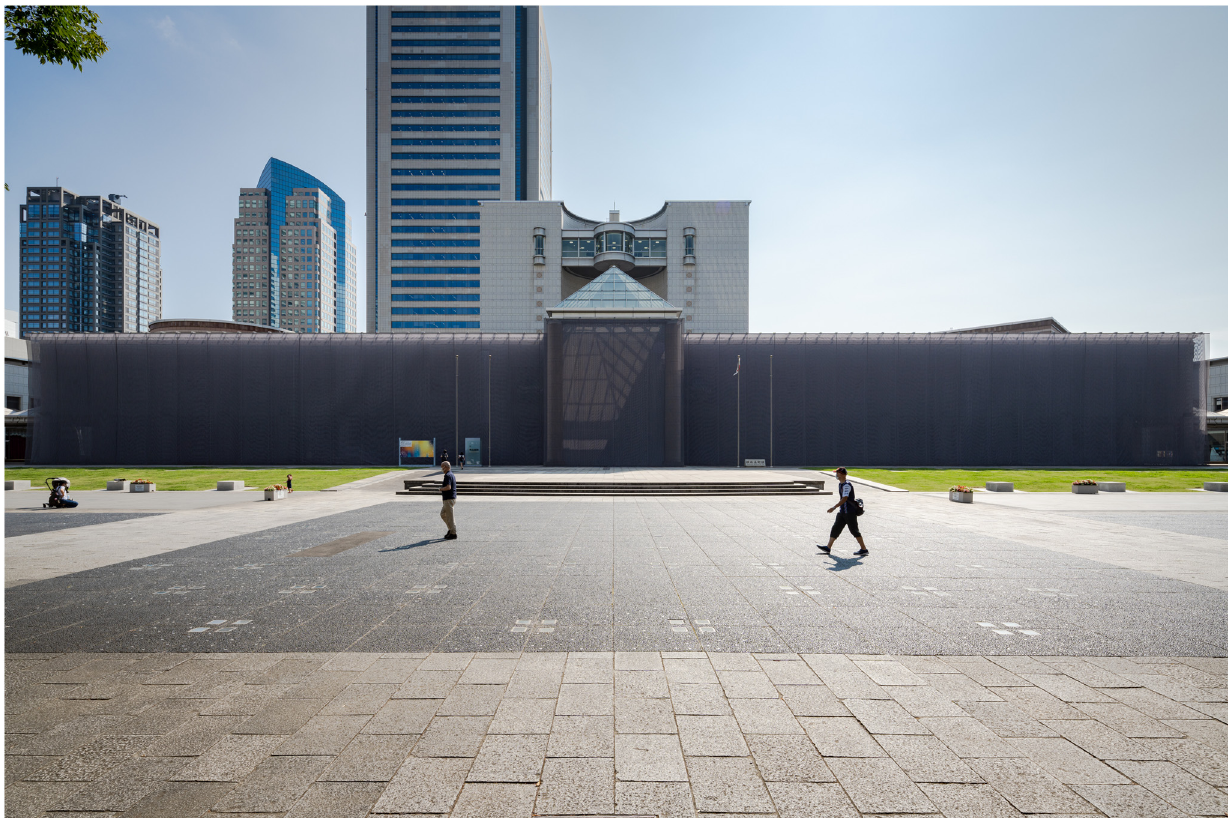
Figure 3. Ivanka Franke, Resonance of the Unforeseen , 2020, Yokohama Triennale . Image courtesy of the Yokohama Triennale.